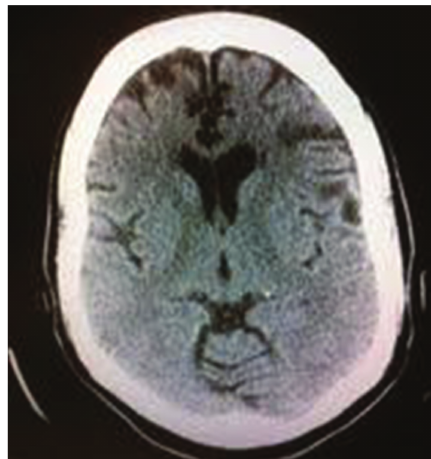
Figure 1: CT scan of the head without contrast showing old bifrontal encephalomalacia (left greater than right).